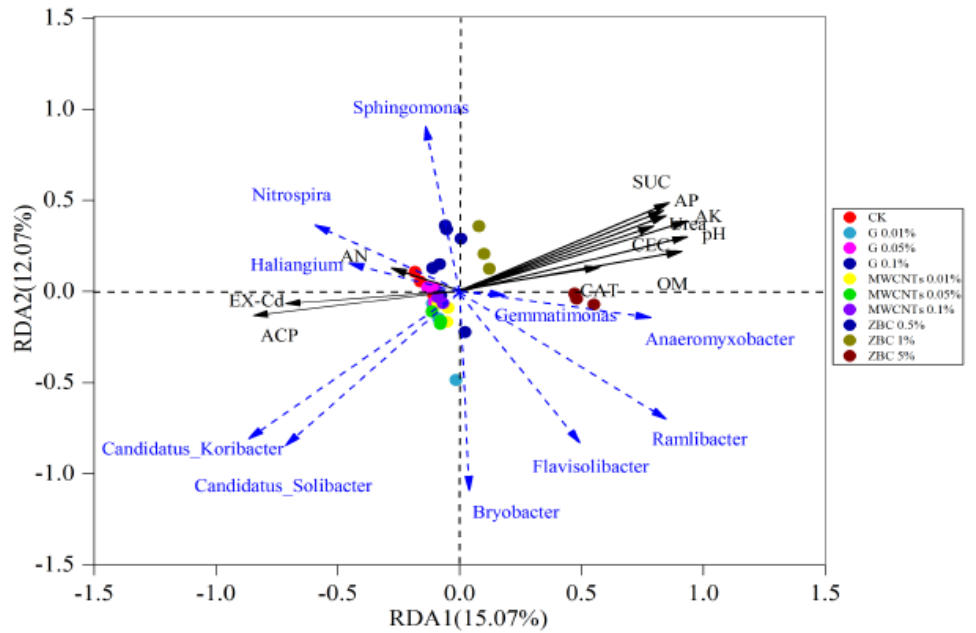
Figure 4. RDA analysis of soil biochemical properties and soil microbial structure at the genus level.